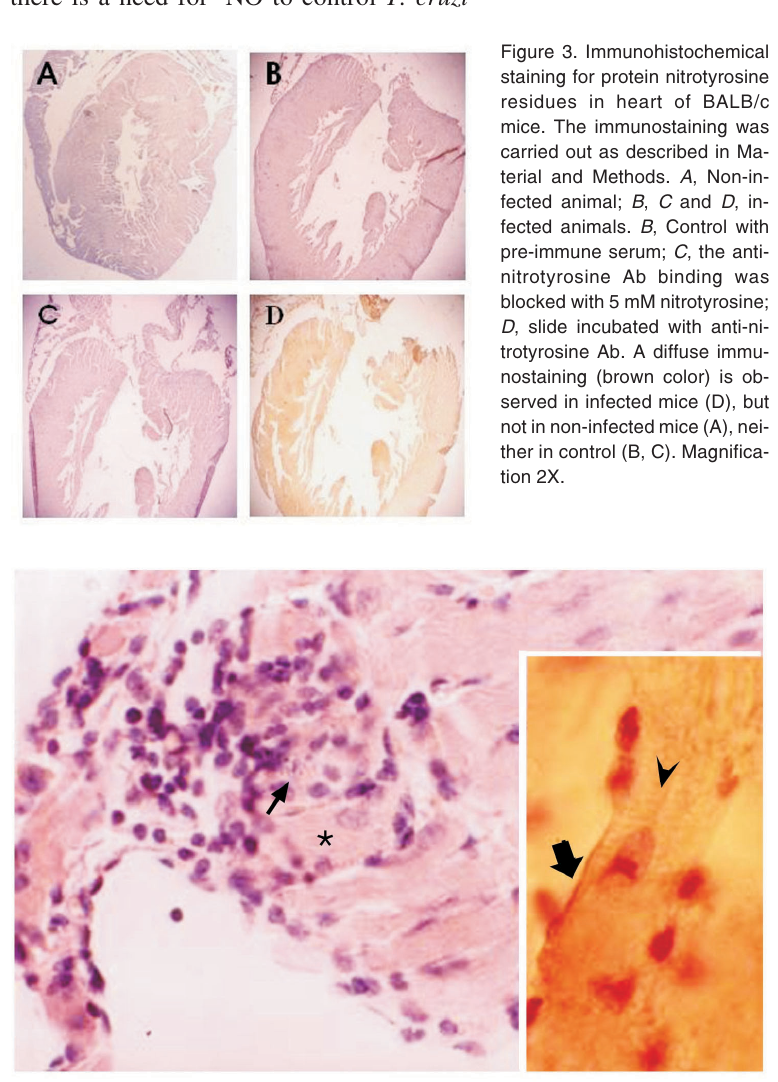
Figure 4. Immunohistochemical staining for protein nitrotyrosine residues in heart of an infected BALB/c mice. Diffuse immunostaining is observed in the myocardium (brown color), with stronger labeling in inflammatory areas, particularly around inflammatory cells (asterisk). Exceptionally, an amastigote nest was found in this slide (thin arrow), (magnifica- tion 10X). Hemalum stain nuclei in dark violet. Insert : NiCl 2 -intensified immunostaining. A strong immunostaining is observed in a myocardial cell membrane (thick arrow) and in the cytoplasm, where the immunostaining shows a clear granular pattern (arrowhead). Magnifi- cation,